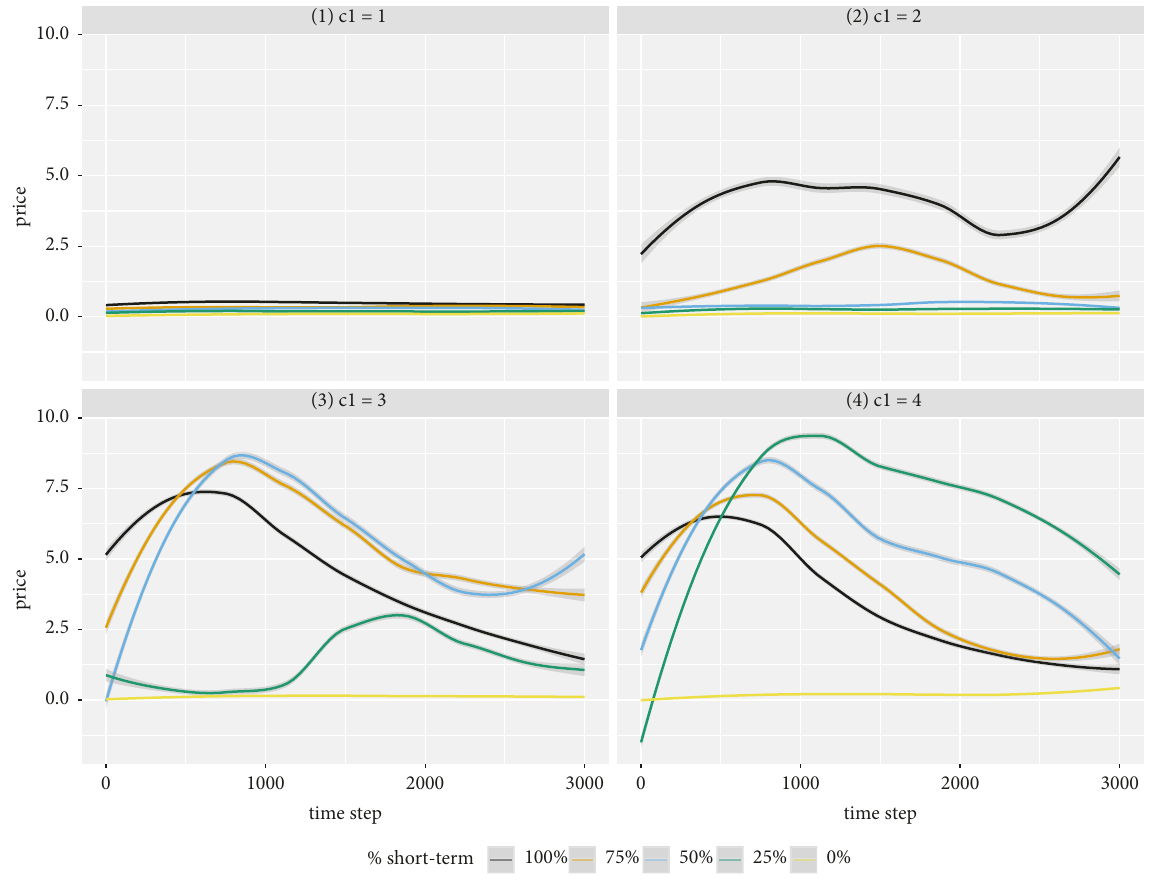
Figure 3: Temporal price behavior of the risky asset with no rewiring. The lines are prepared by applying a LOESS and represent the temporal evolution of the risky asset’s price for the various combination of short- and long-term